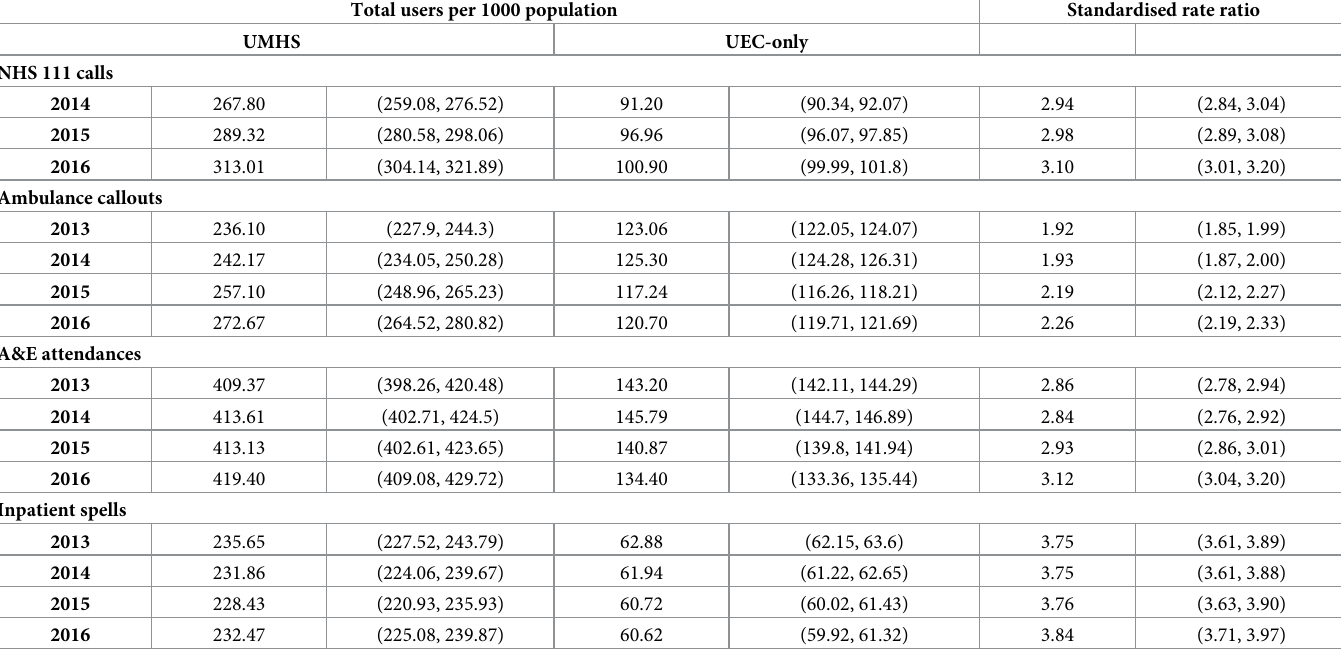
Table 3. Age & sex standardised usage proportion of users (95% confidence intervals) per 1000 population for each UEC service by study year, and comparison as standardised rate ratio